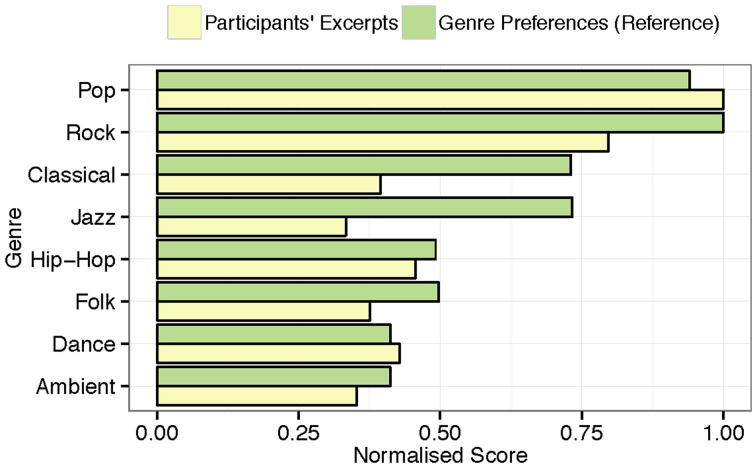
Normalized distribution of musical genres represented by the musical excerpts brought to the lab by the participants and normalized genre preferences from a comparable sample (n = 346).